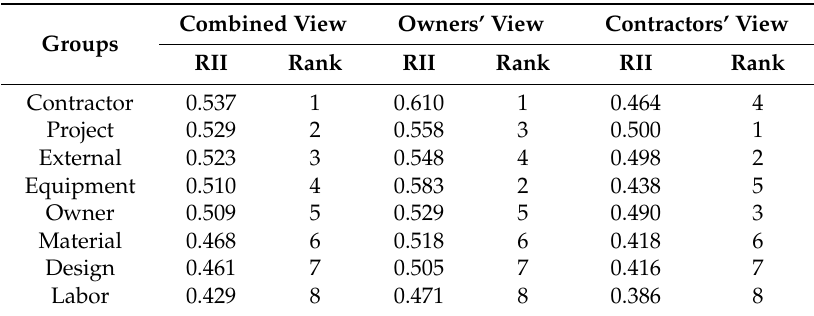
Table 4. A concise explanation of the ranking of groups according to the RII of critical delaying factors follows below. Table 4. Importance Index and Ranking of Major Delays in